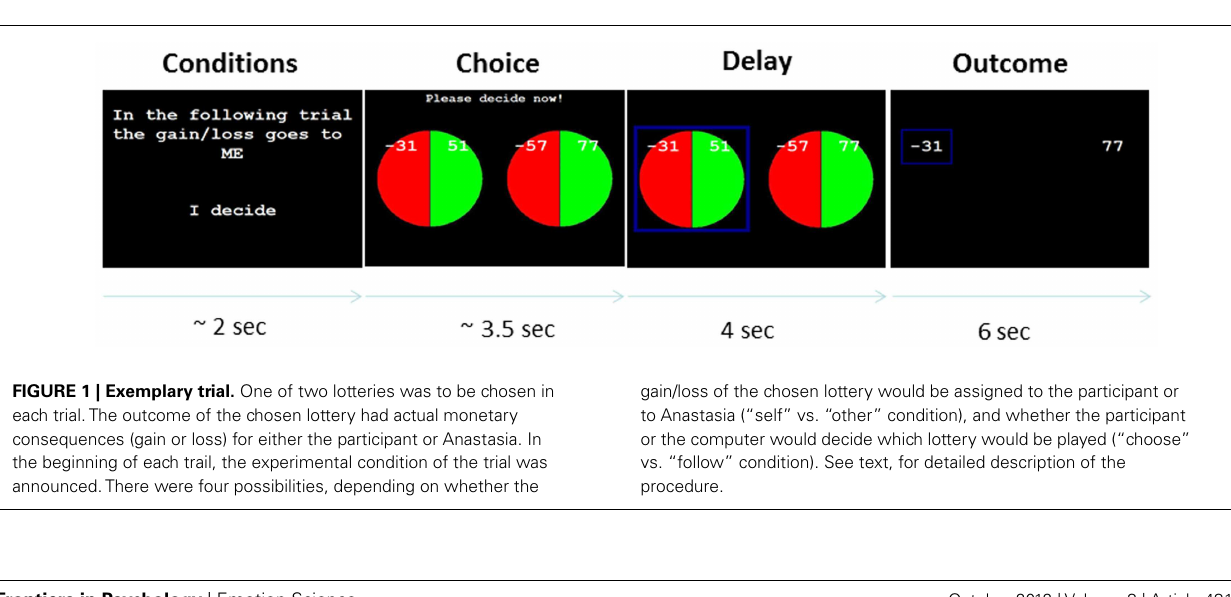
FIGURE 1 | Exemplary trial. One of two lotteries was to be chosen in each trial.The outcome of the chosen lottery had actual monetary consequences (gain or loss) for either the participant or Anastasia. In the beginning of each trail, the experimental condition of the trial was announced.There were four possibilities, depending on whether the